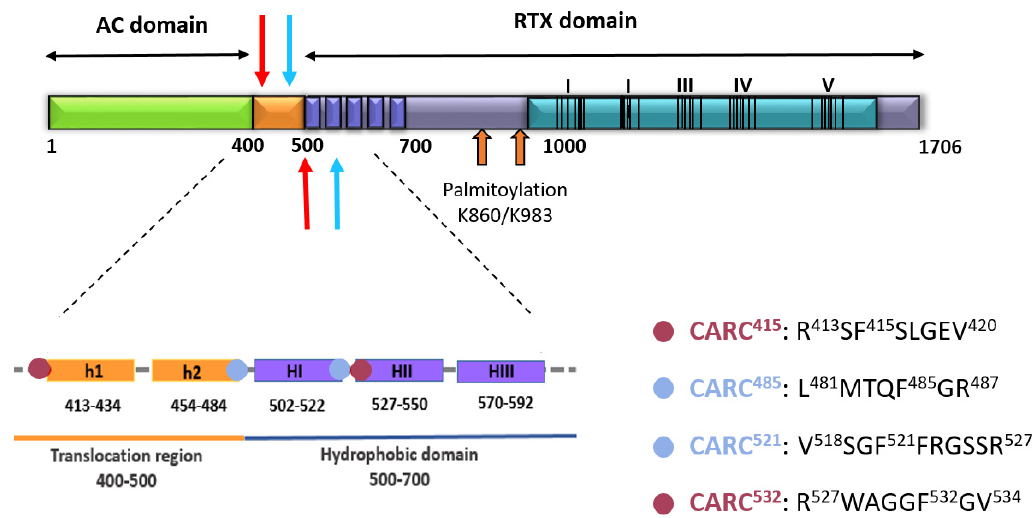
Figure 4. Schematic drawing of the ACT polypeptide chain with the identified four potential cholesterol-recognition motifs. ACT is a 1706-residue-long polypeptide that consists of an N-terminal adenylate cyclase enzyme domain (AC domain, residues 1 to ≈ 400) (in green) that is fused by an “AC to Hly linker segment” of about 100 residues (in orange) so-called translocation region (residues ≈ 400–500) to a pore-forming RTX haemolysin (Hly) moiety of approximately 1200 residues (different blue tones). The RTX haemolysin moiety in turn, contains a hydrophobic pore-forming domain comprising residues 500 to 700, constituted by five alpha-helices (dark blue-coloured five cylinders), an acylated domain between residues 800 and 1000, where the posttranslational acylation at two lysine residues (K860 and K983, two orange arrows) occurs, a typical calcium-binding repeats domain (in light blue) organized in five blocks (I to V) and a C-terminal secretion signal (last ≈ 100 residues). Two predicted α -helices in the translocation region, namely, h1 and h2 (in orange), and three of the five predicted amphipathic/hydrophobic helices of the pore-forming domain, namely HI, HII and HIII (in dark blue) have been depicted below with greater detail. Blue or red spots have been used in the scheme below to specify the location of each one of the four potential cholesterol- recognition motifs identified in this study (CARC 415 , CRAC 485 , CRAC 521 and CARC 532 ). Sequences of each one of the motifs are specified on the right side of the scheme. The respective N-terminal leucine/valine or arginine, the central phenylalanine (F415, F485, F521 and F532) and the C-terminal arginine or valine residues of the predicted CRAC and CARC motifs are specified. The four motifs are also indicated with blue and red arrows in the schematic drawing of the ACT